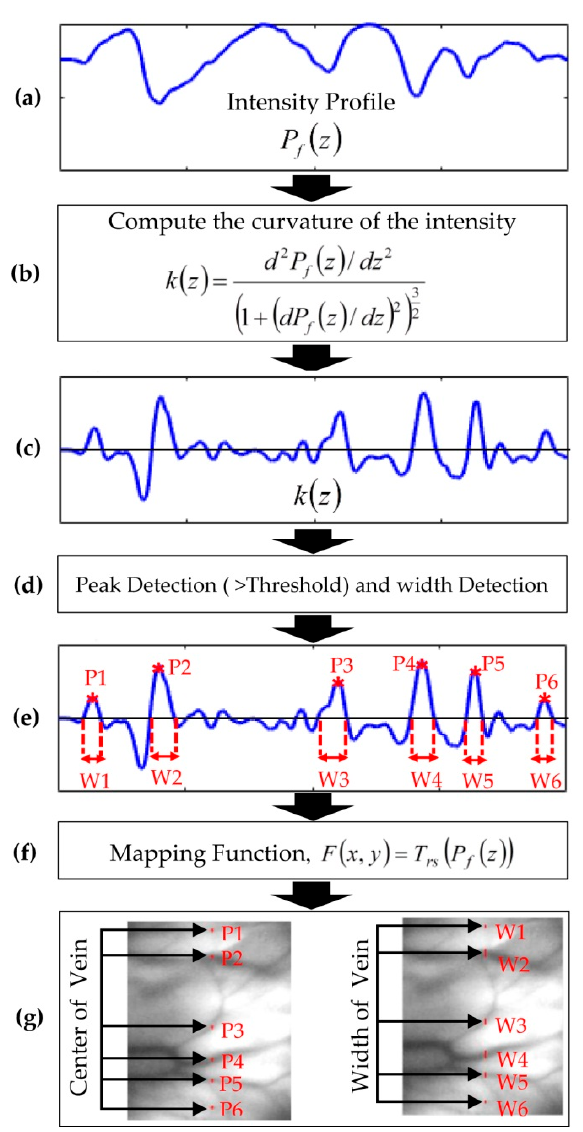
Figure 11. Vein extraction process: ( a ) intensity profile of vein image; ( b ) compute the curvature of the intensity; ( c ) curvature of the intensity; ( d ) compute peak detection and width detection; ( e ) peak and width detection’s position; ( f ) mapping function of ( a ) and ( e ); and ( g ) result of vein extraction.